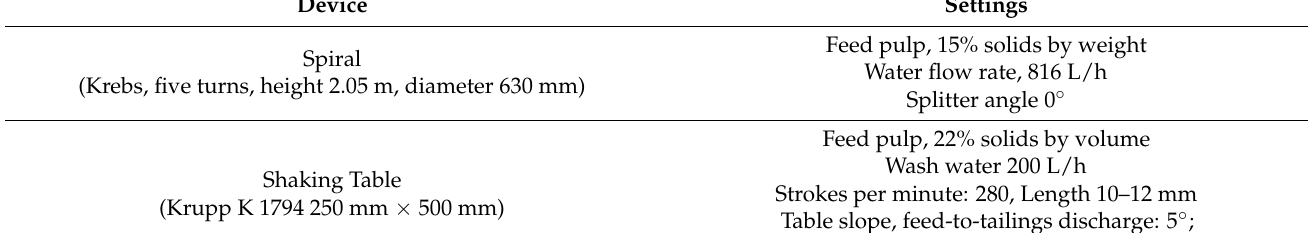
Table slope, feed-to-tailings discharge: 5 ◦ ;